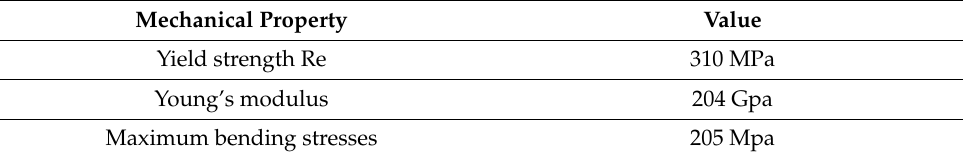
Table 2. Mechanical property of C45